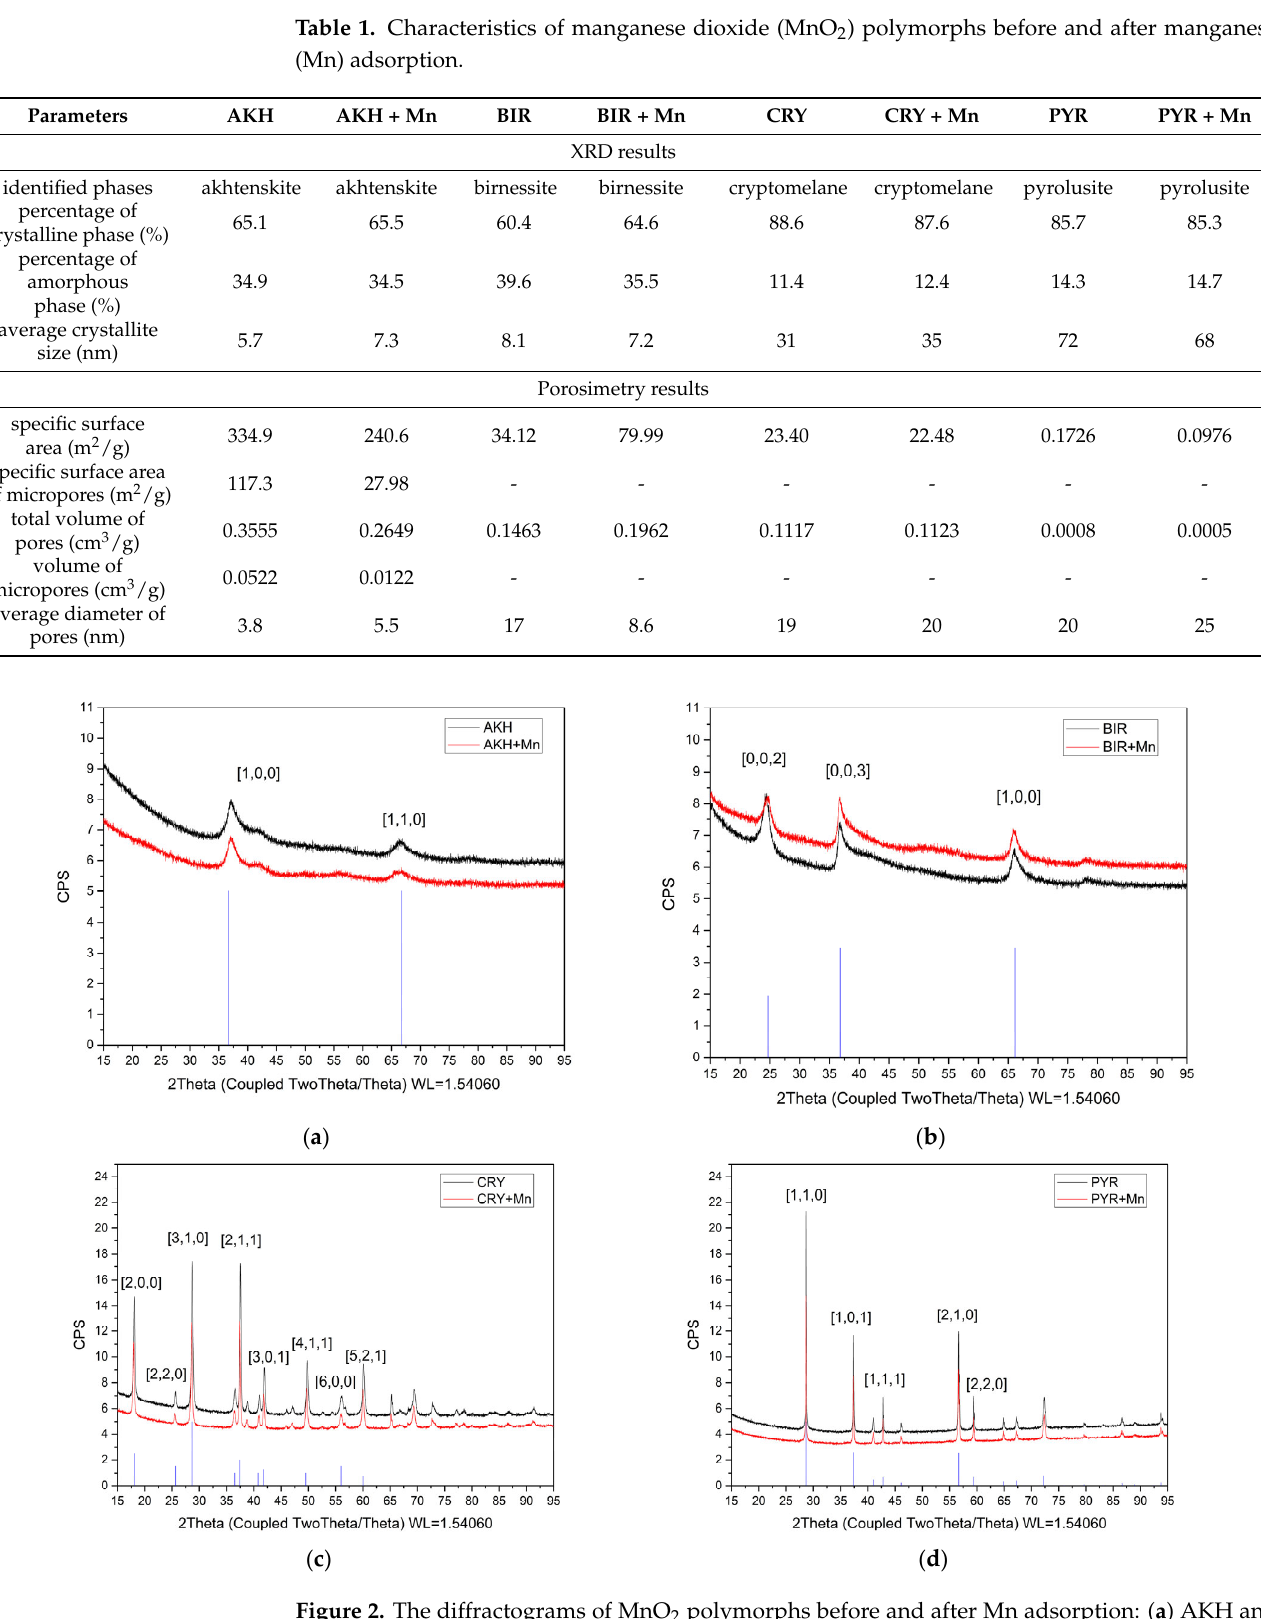
Figure 2. The diffractograms of MnO 2 polymorphs before and after Mn adsorption: ( a ) AKH and AKH + Mn; ( b ) BIR and BIR + Mn; ( c ) CRY and CRY + Mn; ( d ) PYR and PYR + Mn. The XRD JCPDS codes are as follows: ( a ) 00 ‐ 030 ‐ 0820, ( b ) 00 ‐ 013 ‐ 0105, ( c ) 00 ‐ 004 ‐ 0603 and ( d ) 00 ‐ 024 ‐ 0735.